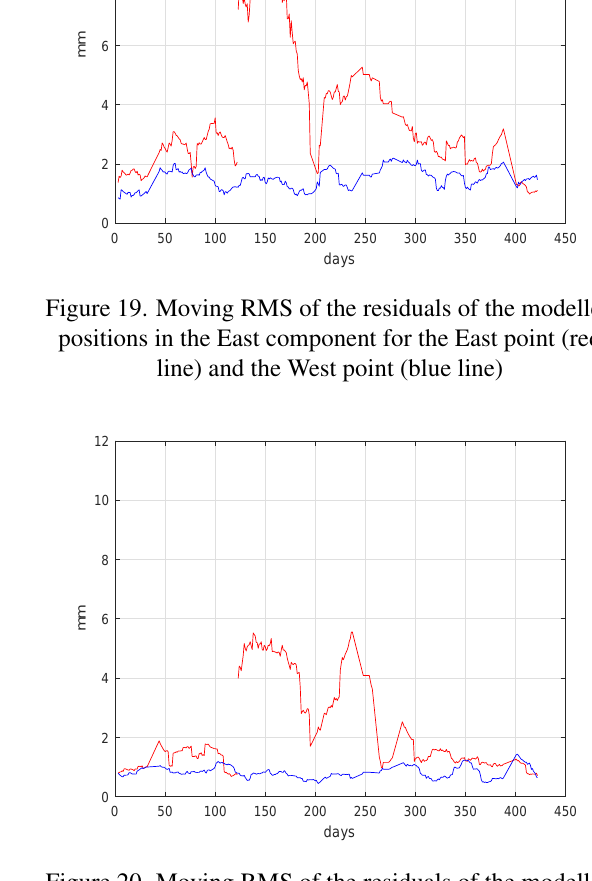
Figure 20. Moving RMS of the residuals of the modelled positions in the North component for the East point (red line) and the West point (blue line)